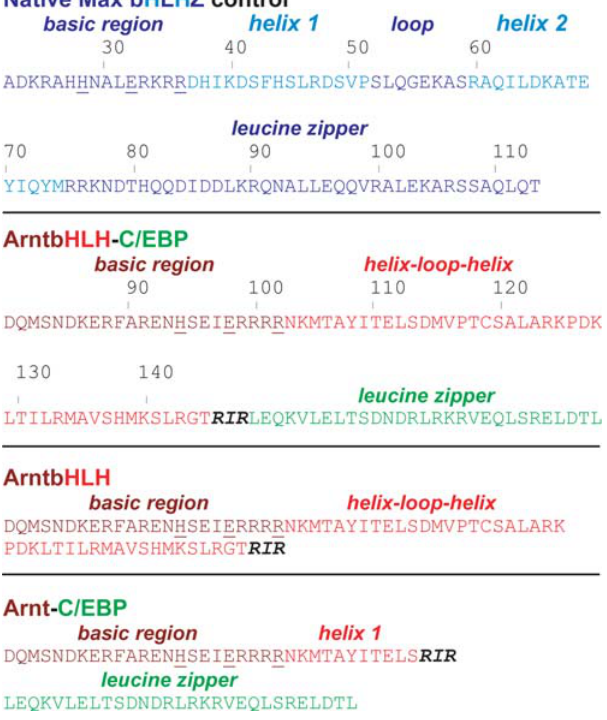
Figure 2. Sequences of hybrid proteins. Max sequences are highlighted in blue, Arnt sequences in red, and C/EBP leucine zipper in green; different shades of blue or red highlight individual components of Max and Arnt. Highly conserved basic-region residues that make sequence-specific contacts to DNA bases in crystal structures are underlined (His28, Glu32, Arg36) [7,8]. Arnt bHLH components are putative and based on sequence similarity; His94, Glu98, and Arg102 of Arnt aligning with His28, Glu32, and Arg36 of Max are underlined. The nonnative RIR linker is highlighted in bold, black.